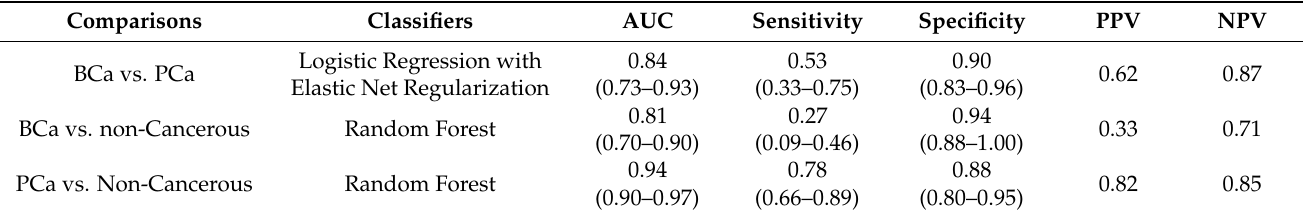
Table 3. GC-TOF-MS diagnostic group results.